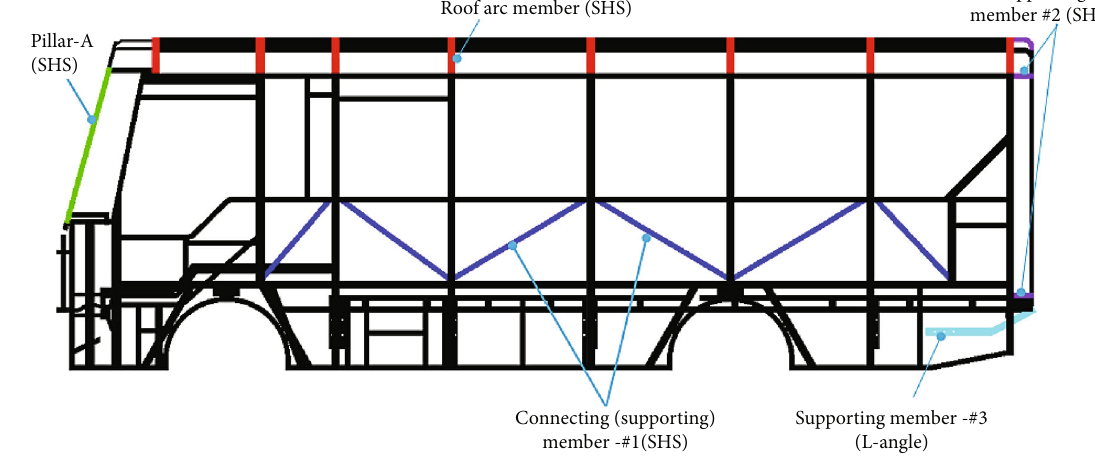
Figure 8: Enhanced con fi gurations of the reinforced design in a side view. Table 4: Components with its mass of enhanced con fi